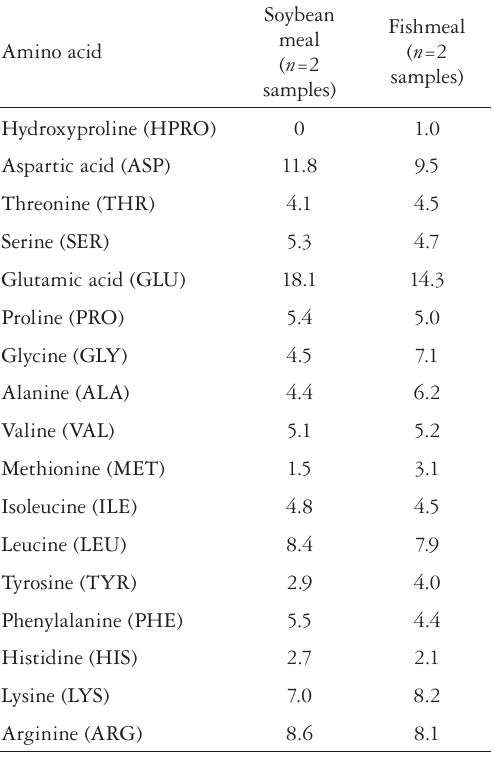
Table 2. Amino acid composition (mean values; % of total identified amino acids) of the two protein supplements used in the study; soybean meal and